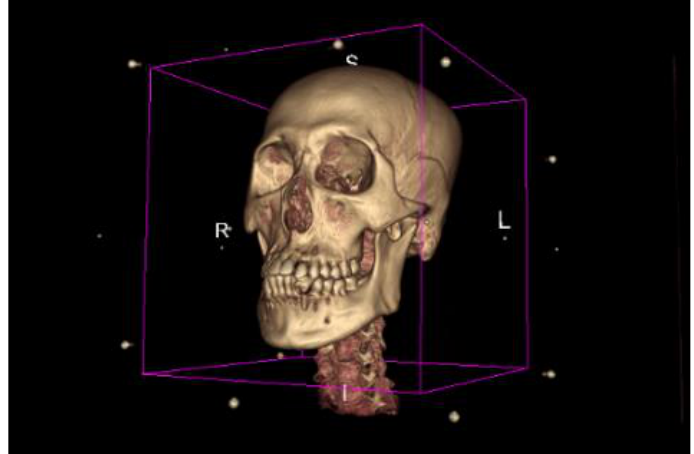
Figure 2. CT rendering of the brain model.